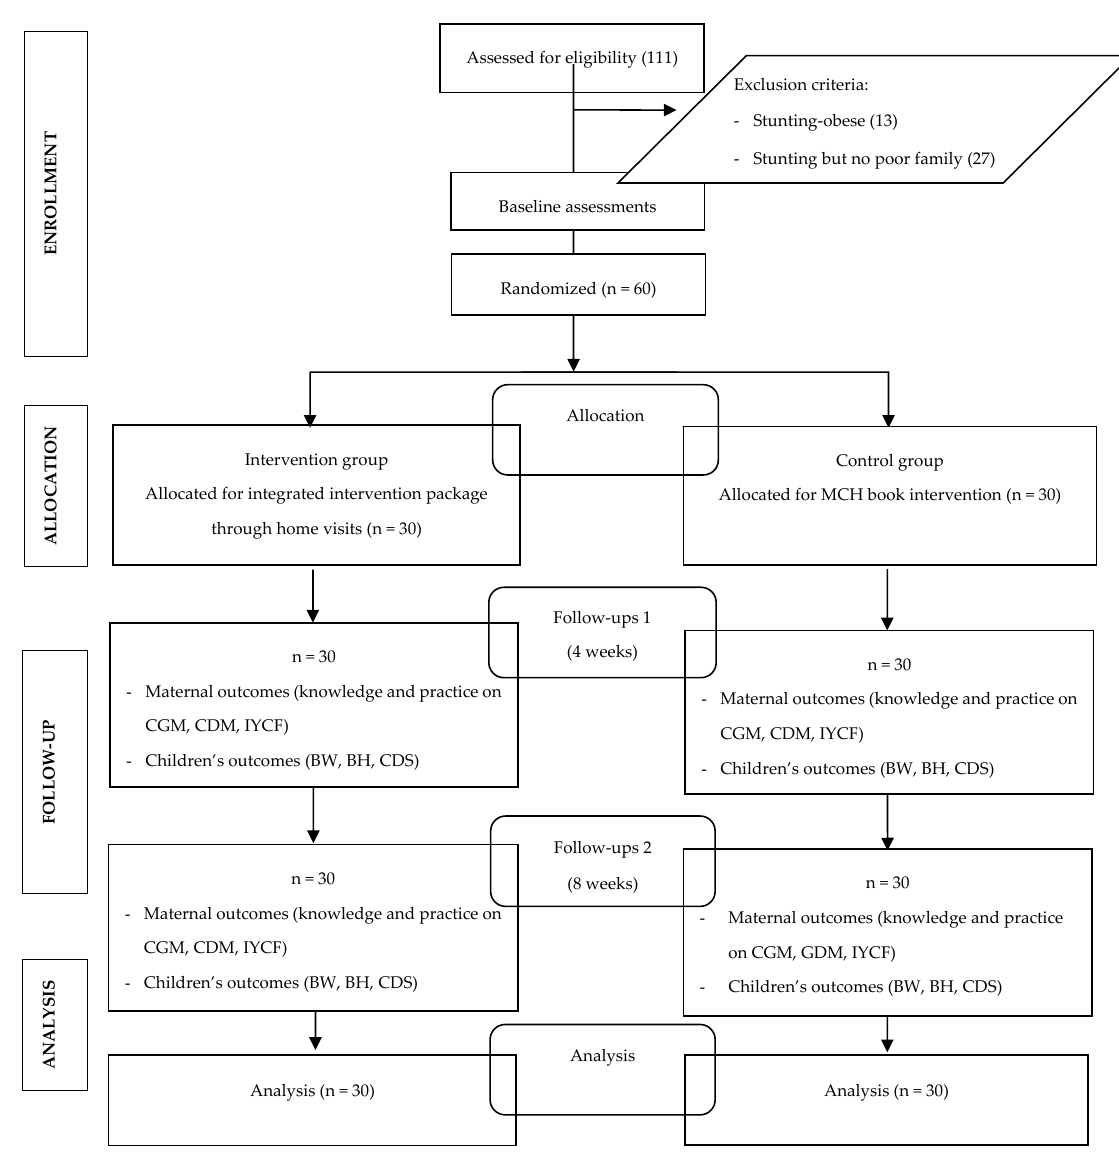
Figure 1. CONSORT diagram of this study.